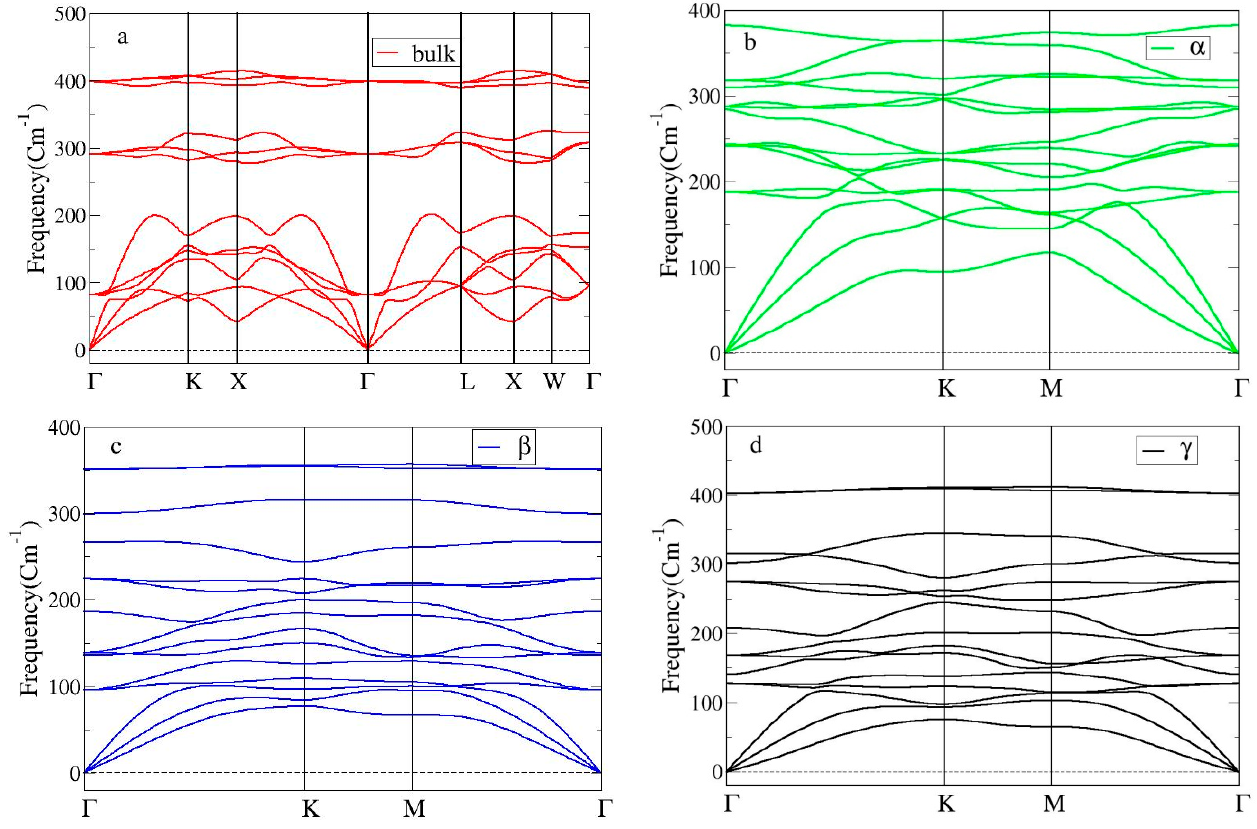
Figure 3. Phonon BSs of Co 2 CrAl in four different phases: ( a ) Bulk, ( b ) α -, ( c ) β -, and ( d ) γ -Heuslerene shapes.